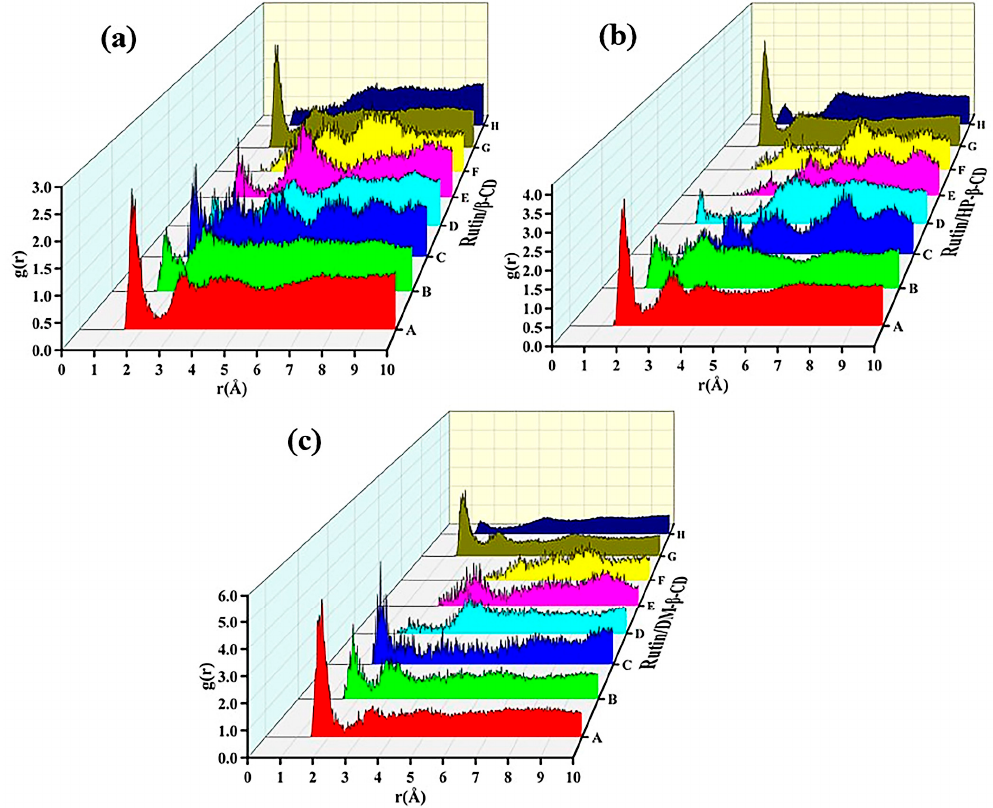
Figure 13. RDF of ( a ) rutin/ β -CD IC, ( b ) rutin/HP- β -CD IC and ( c ) rutin/DM- β -CD IC.